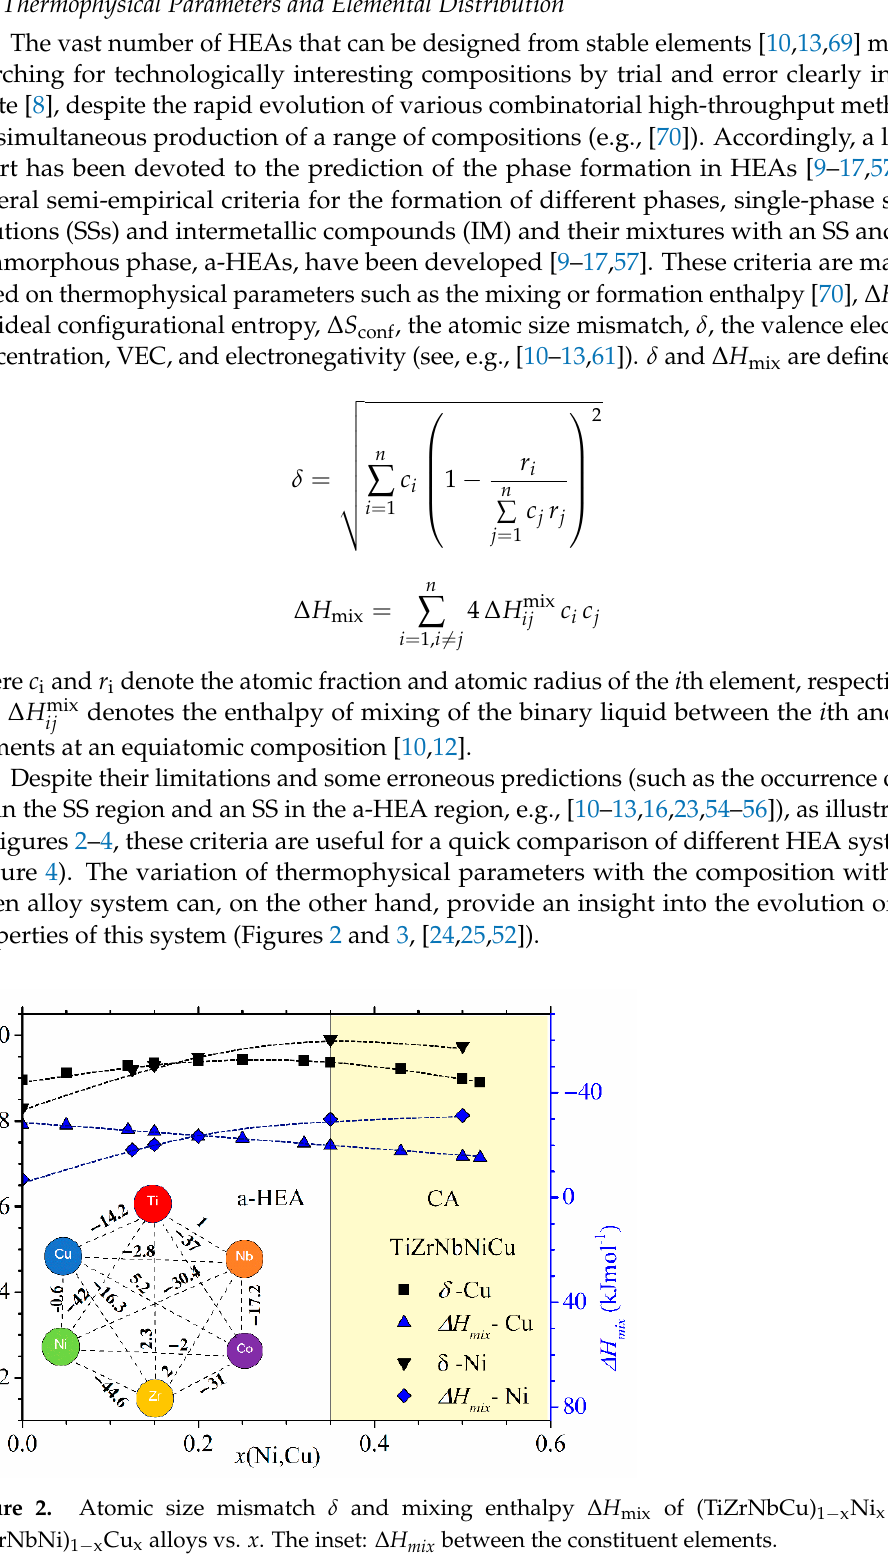
Figure 3. Atomic size mismatch δ and mixing enthalpy ∆ H mix of (CrMnFeCo) 1 − x Ni x and (CrM- nCoNi) 1 − x Fe x alloys vs. x . The inset: ∆ H mix between the constituent elements. Figure 4. A plot of ∆ H mix vs. δ showing the data for (CrMnFeCo) 1 − x Ni x and (TiZrNbCu) 1 − x Ni x alloys. Data for conventional alloys (CAs) are denoted with different symbols. Black oval encompasses al- loys comprising intermetallic compounds.